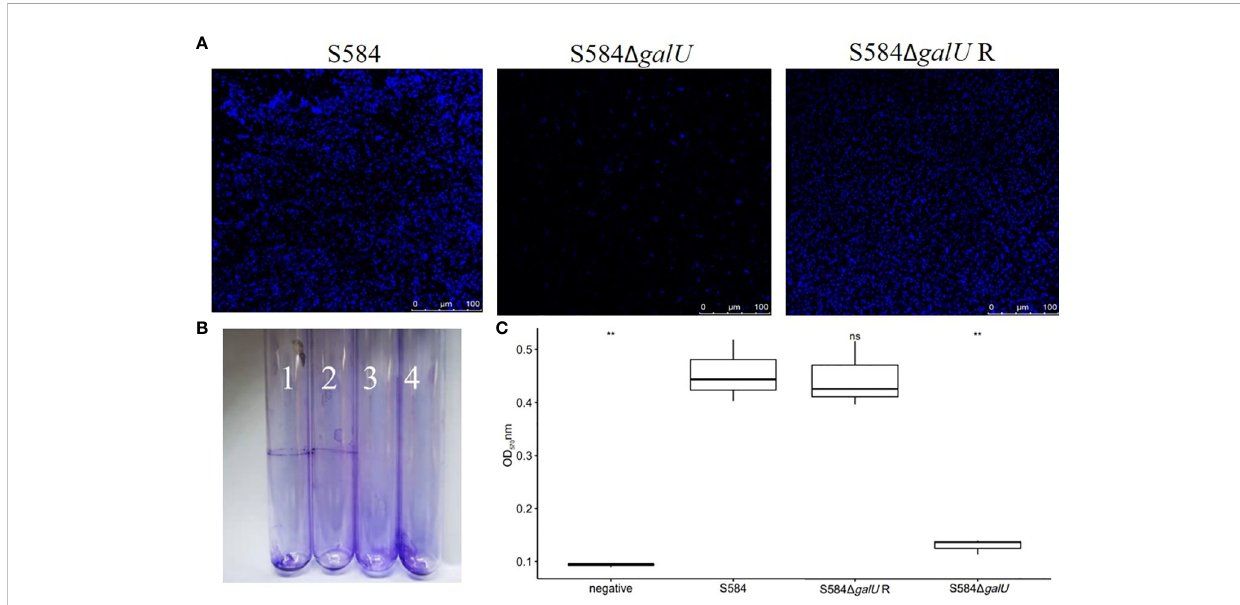
FIGURE 6 Bio fi lm formation ability. (A) Confocal laser scanning microscopy analysis. (B) Photographs of test tubes from binding assays. (C) Bio fi lm production of the three bacterial strains cultured in a 96-well microplate for 48 h. Results are mean ± standard error of the mean (SEM). The bottom dashed line shows the node where the bio fi lm was measured (ODc = 0.1651). According to the OD value, strains were divided into four categories: non- bio fi lm producers (OD ≤ ODc), weak bio fi lm producers (ODc <OD ≤ 2×ODc), medium bio fi lm producers (2×ODc <OD ≤ 4×ODc), and strong bio fi lm producers (2ODc <OD). Ns means no signi fi cant difference. ** means signi fi cant difference.